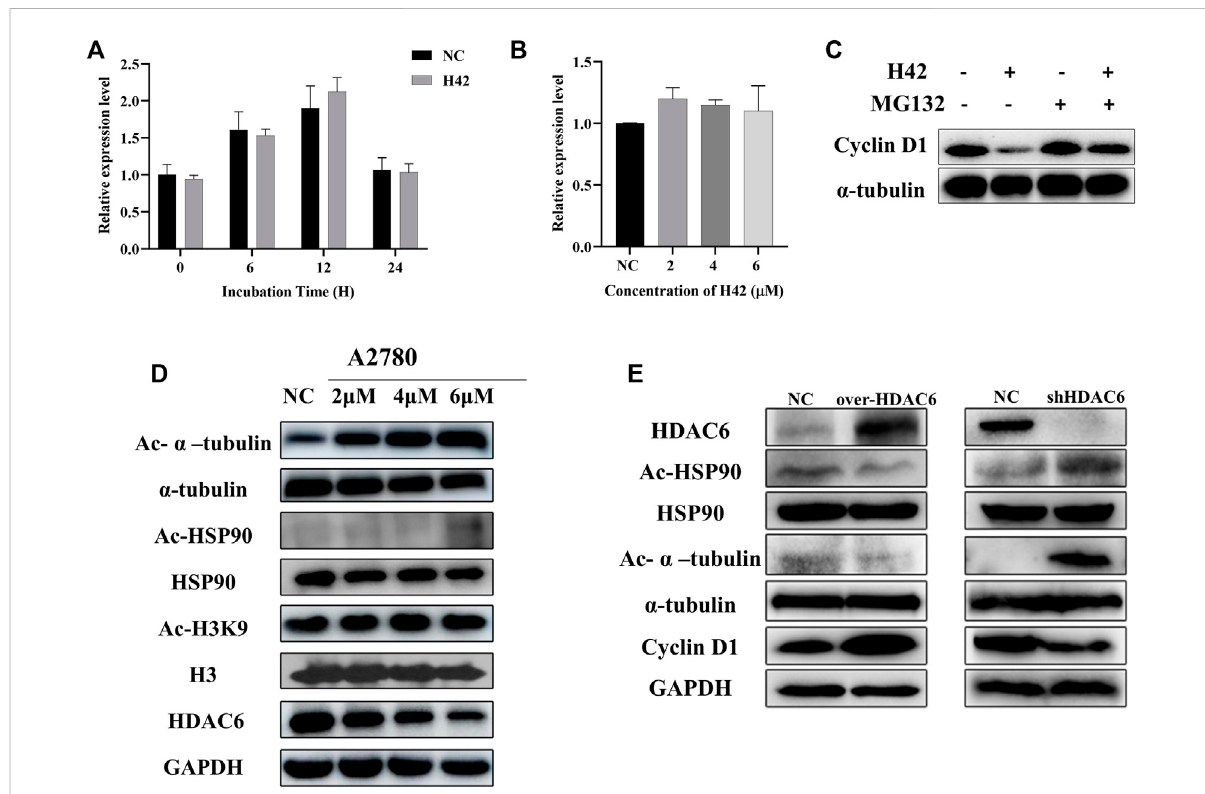
FIGURE 9 Compound H42 induced the degradation of cyclin D1 via HDAC6. (A) mRNA levels of cyclin D1 at speci fi c points were detected by qPCR. (B) mRNA levels of cyclin D1 after different concentrations of H42 treatment were detected by qPCR. (C) H42 promoted cyclin D1 degradation. (D) H42 downregulated HDAC6 expression and upregulated the acetylation of α -tubulin and HSP90 in ovarian cancer cells. (E) Protein expression was detected in HDAC6 overexpression ovarian cancer cells and shHDAC6 A2780